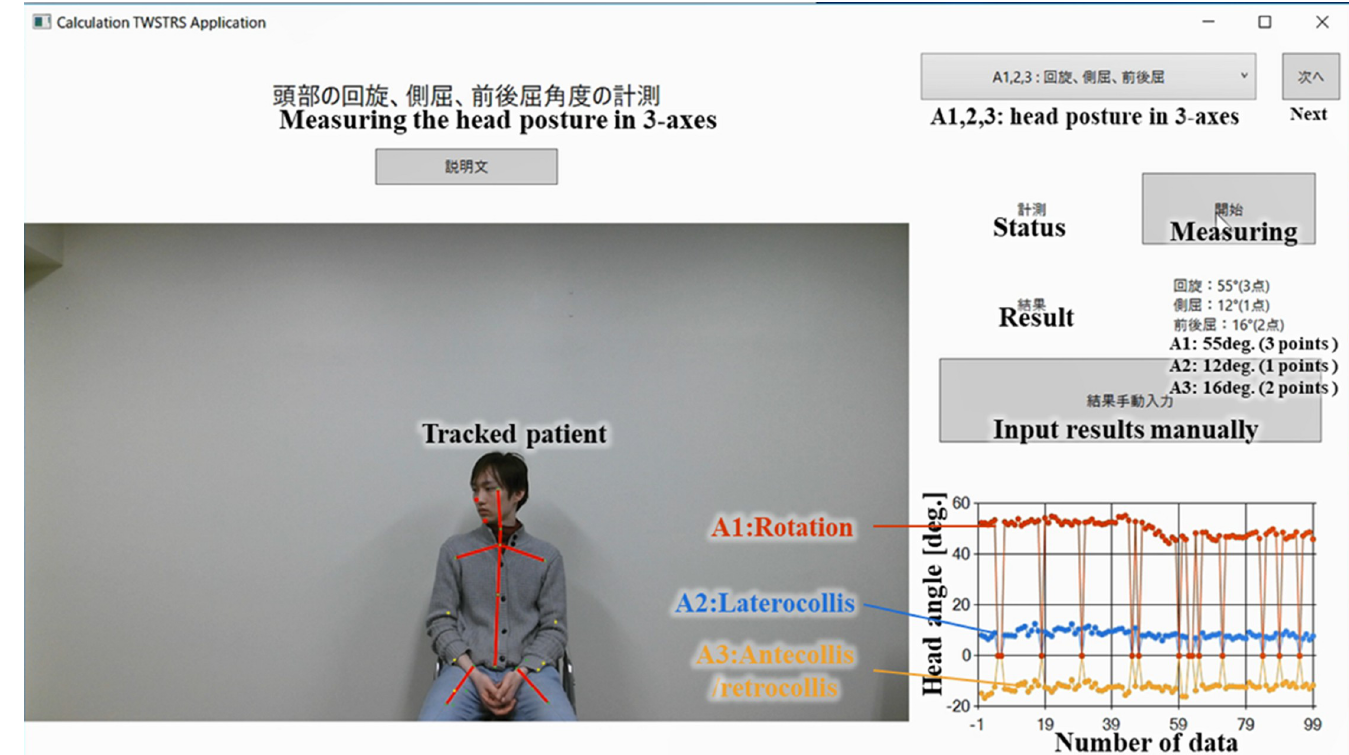
Fig 1. The interface of the system for semi-automated TWSTRS scoring.